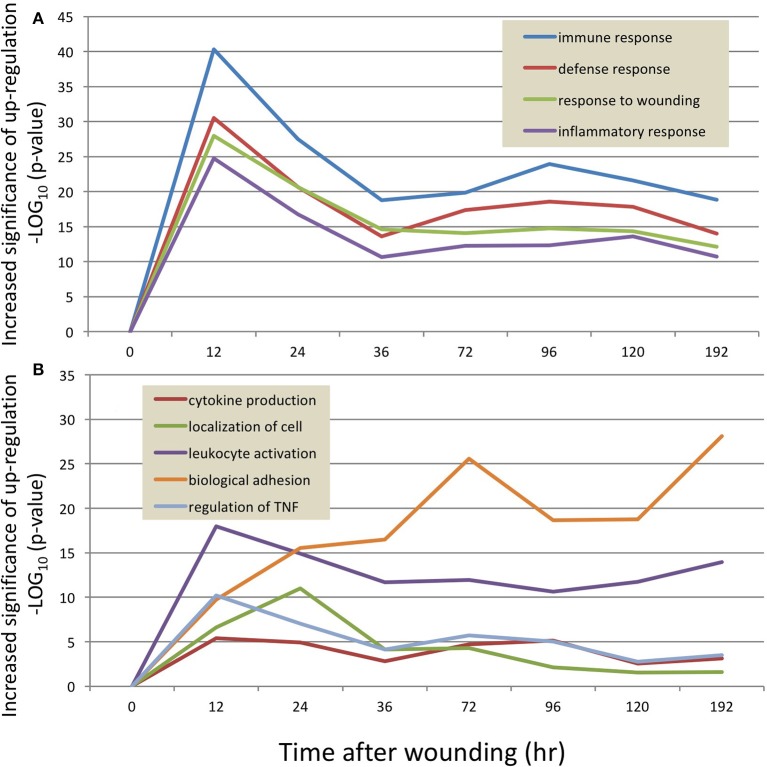
The temporal response of the transcriptome to wounding of the mouse dermis. RNA sequencing results were analyzed at each time point (X axis) to identify transcripts which differed significantly from the 0 h uninjured control sample. The resulting transcripts were then categorized into pre-curated ontologies, and the ontologies with the greatest activity are plotted as a function of the probability that the ontology is activated disproportionately to a random sample of transcripts (Y-axis, p-value, log10scale). Because an ontology may contain ~200 transcripts, at any time point there might be transcripts that are increased or decreased in magnitude relative to the control time point. (A) shows 4 ontologies with the highest statistical probability of being increased at the 12 h time point, whereby the “immune response” ontology (blue line) is over-represented at a probability of ~10−40 compared to a random set of transcripts. (B) depicts 5 ontologies that are engaged in the 24–72 h time frame.